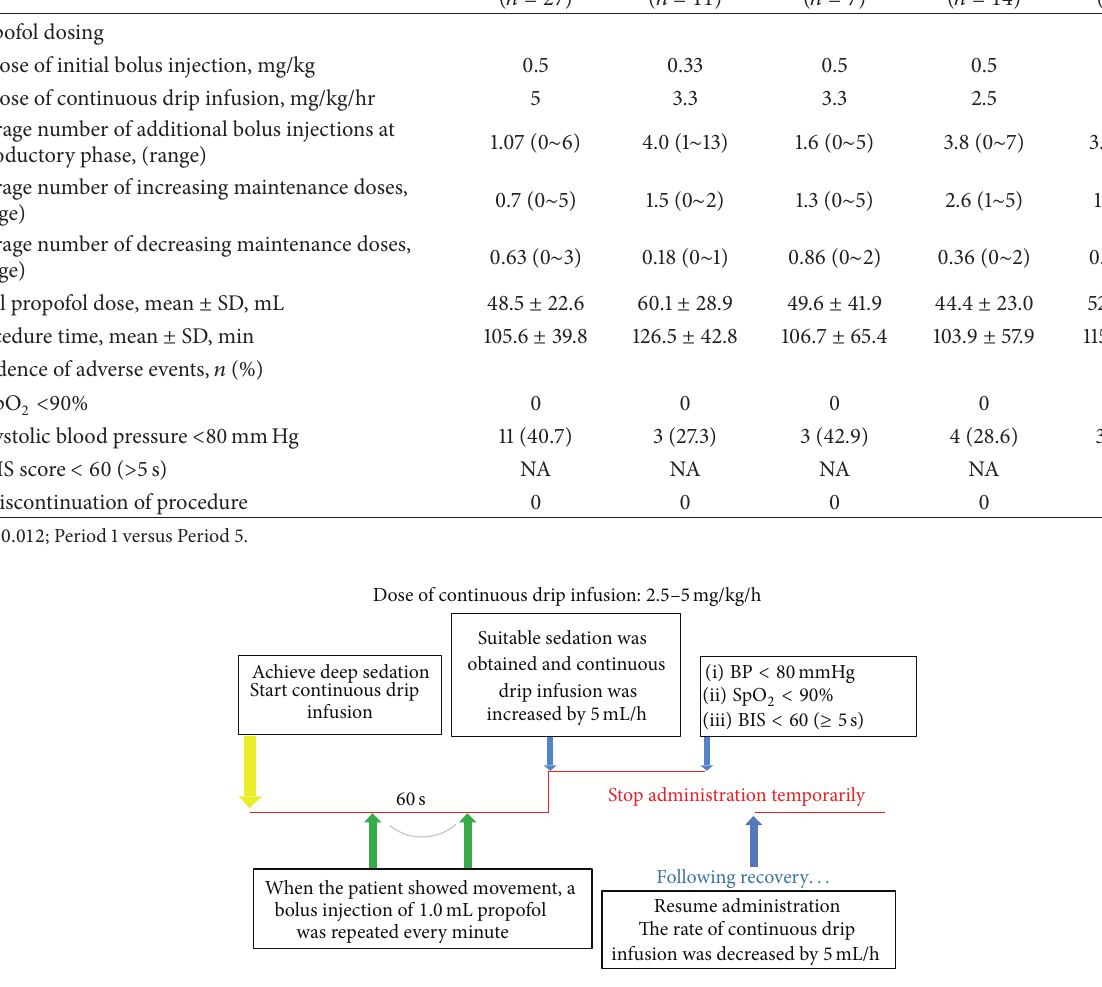
Figure 2: Maintenance of sedation. (1) Continuous drip infusion was performed using an automatic infusion pump (atom syringe pump S-1235; Atom Medical Corp.). (2) When the patient moved, a bolus injection of 1.0 mL propofol was repeated every min until suitable sedation was obtained. The infusion rate was increased by 5 mL/h. (3) Continuous drip infusion was stopped temporarily under the following conditions: SpO 2 < 90%, systolic blood pressure (SBP) < 80 mmHg, or BIS score < 60 ( ≥ 5 s). (4) Following recovery, the infusion rate was decreased by 5